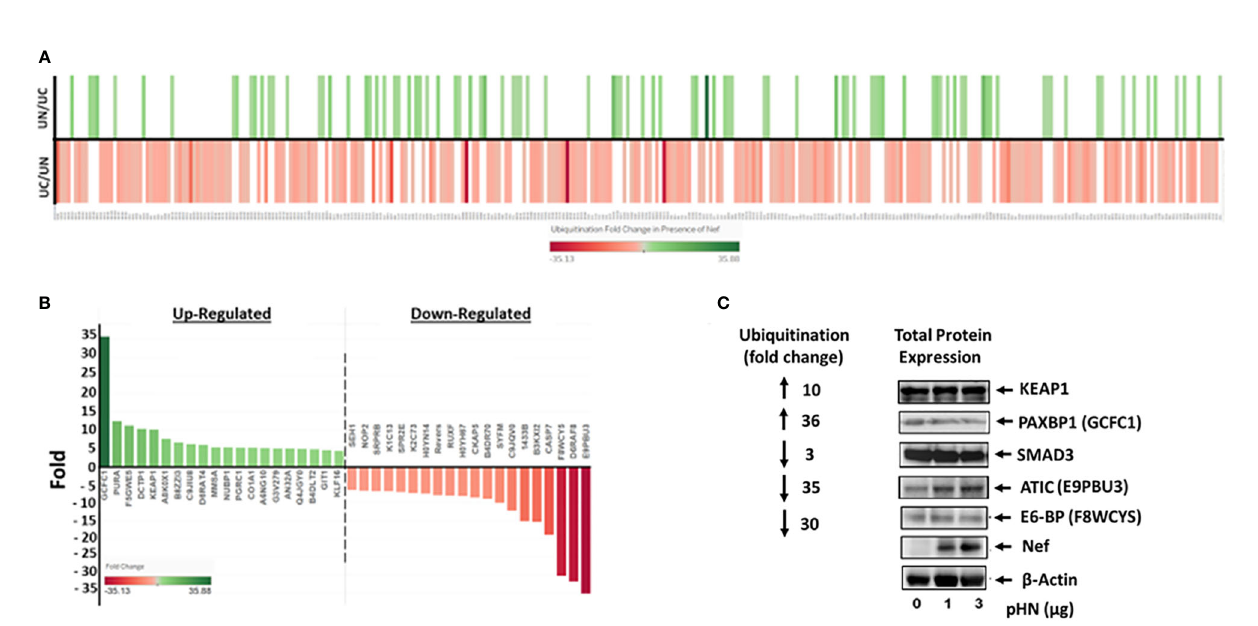
FIGURE 2 HIV-1 Nef-mediated differential ubiquitination of individual cellular proteins. (A) Heatmap showing Nef-mediated ubiquitination fold change of cellular proteins. The identi fi ed 325 cellular proteins that are differentially ubiquitinated in the presence of Nef with statistical signi fi cance are labeled along the X-axis, while increases and decreases of ubiquitination of cellular proteins in the presence (UN) and absence (UC) of Nef, respectively, are depicted on the Y-axis; that is, increases in the presence of Nef (UN/UC) are shown by a green line, whereas decreases in ubiquitination in the presence of Nef are indicated by a red line in the UC/UN. Color intensities of each line correspond to fold changes in ubiquitination of the indicated cellular proteins. (B) Top 20 positive and negative ubiquitination fold changes of cellular proteins in the presence of Nef. (C) Validation of Nef-mediated differential ubiquitination of cellular proteins. The level of expression of the indicated proteins in the presence of Nef was nominal, while that of ubiquitination of the proteins was profoundly increased (KEAP1 and PAXBP1) or decreased (SMAD3, ATIC, and E3-BP), indicating that changes in ubiquitination of these proteins were not due to the expression of each protein. Parentheses represent aliases of the indicated genes in part label (B)